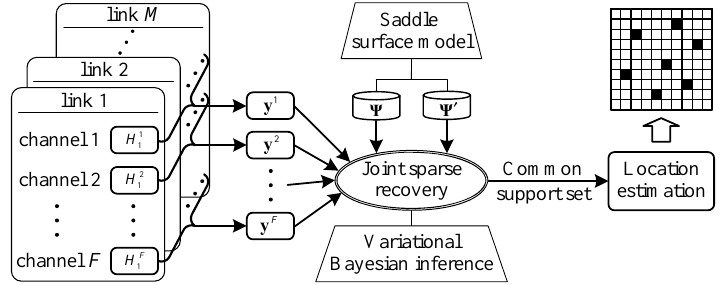
Figure 3. Architecture of the ComDec